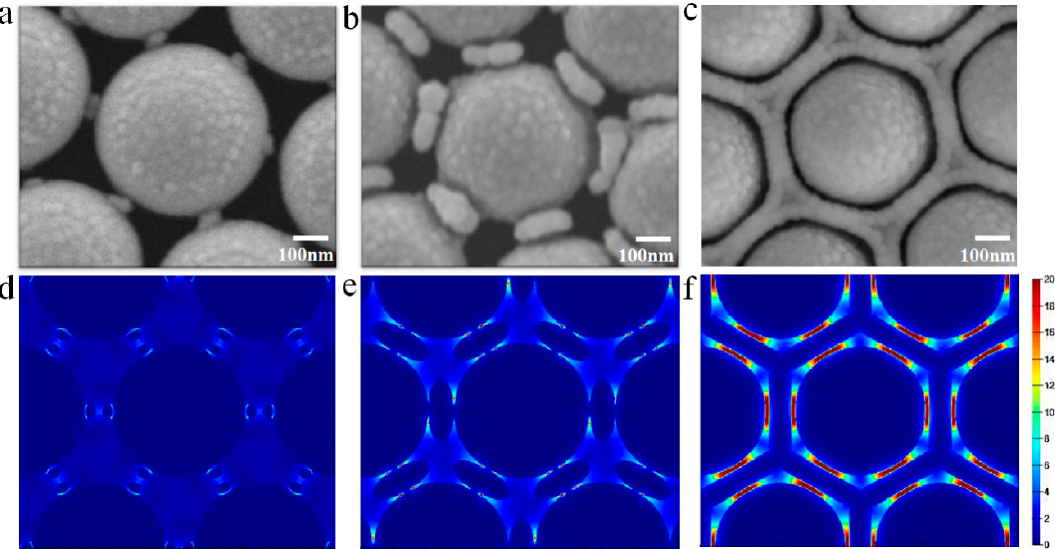
Figure 2. ( a – c ) SEM images of the process of honeycomb nanostructure formation with di ff erent Figure 2. ( a − c ) SEM images of the process of honeycomb nanostructure formation with different deposition times (5, 20, and 40 min, respectively). ( d – f ) The finite-di ff erence time-domain (FDTD) deposition times (5, 20, and 40 min, respectively). ( d − f ) The finite-difference time-domain (FDTD) simulation for sectional views of the local EM field distribution in the process of honeycomb nanostructure formation. Reproduced with permission from [38] American Chemical Society,